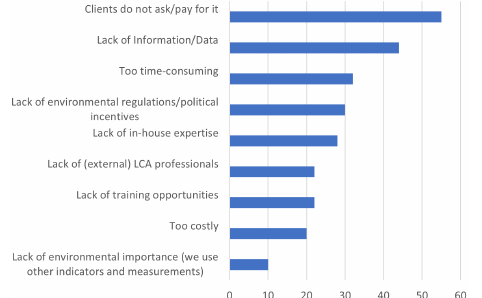
Figure 9. Perceived barriers of environmental per- fomance assessments (based on 72 respondents, more than one answer could be selected).